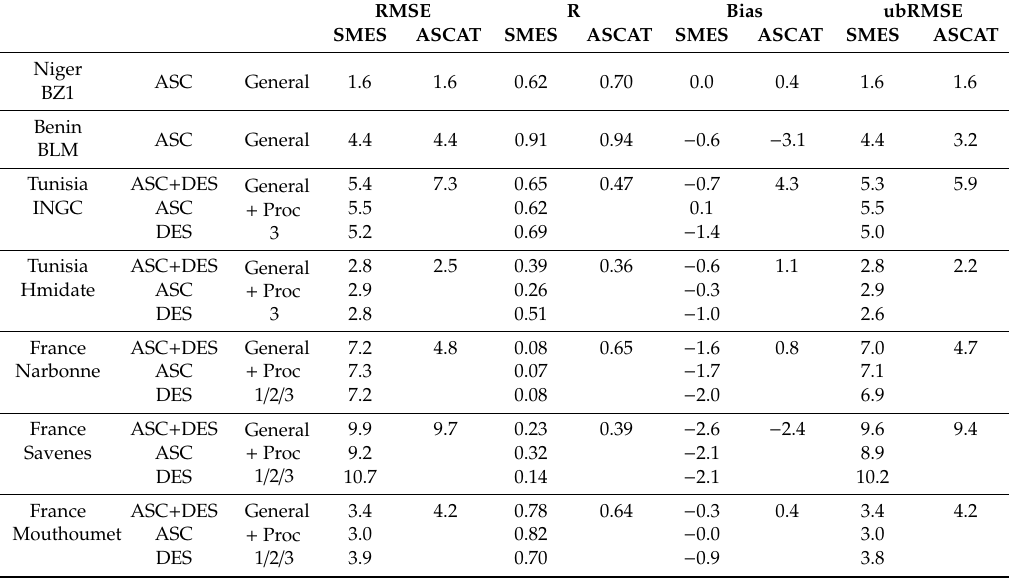
Table 3. RMSE, R, bias, and ubRMSE on surface soil moisture (vol.%) for all sites (VV